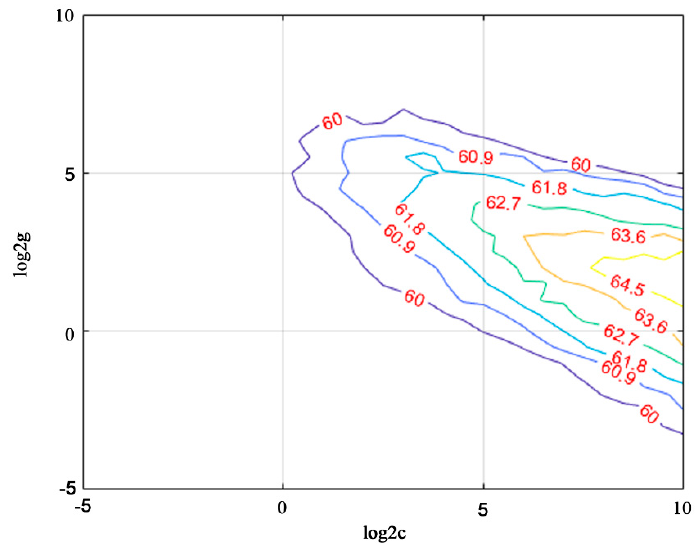
Figure 13. Training for c and g values for the RBF kernel of the SVM classifier. LIBSVM uses an All-versus-All strategy to achieve multi-label classification. We directly used the multi-classification solution for our classification. The pre-classification result in Kent County is as shown in Figure 14a. Membership in the selected land cover types including impervious, forest, and agriculture is also shown in Figure 14.